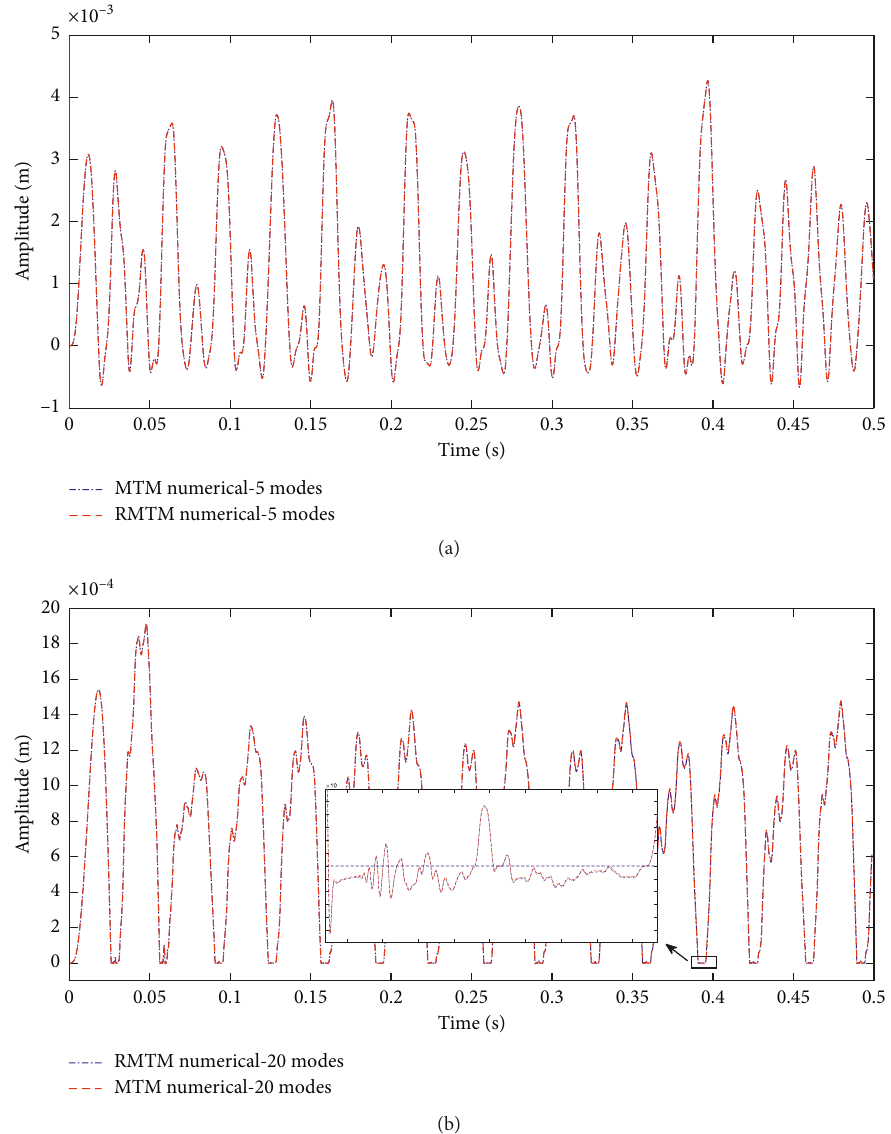
Figure 5: Time-history response of soft impact and hard impact using MTM and RMTM. (a) Five-mode discretization: damping ratio